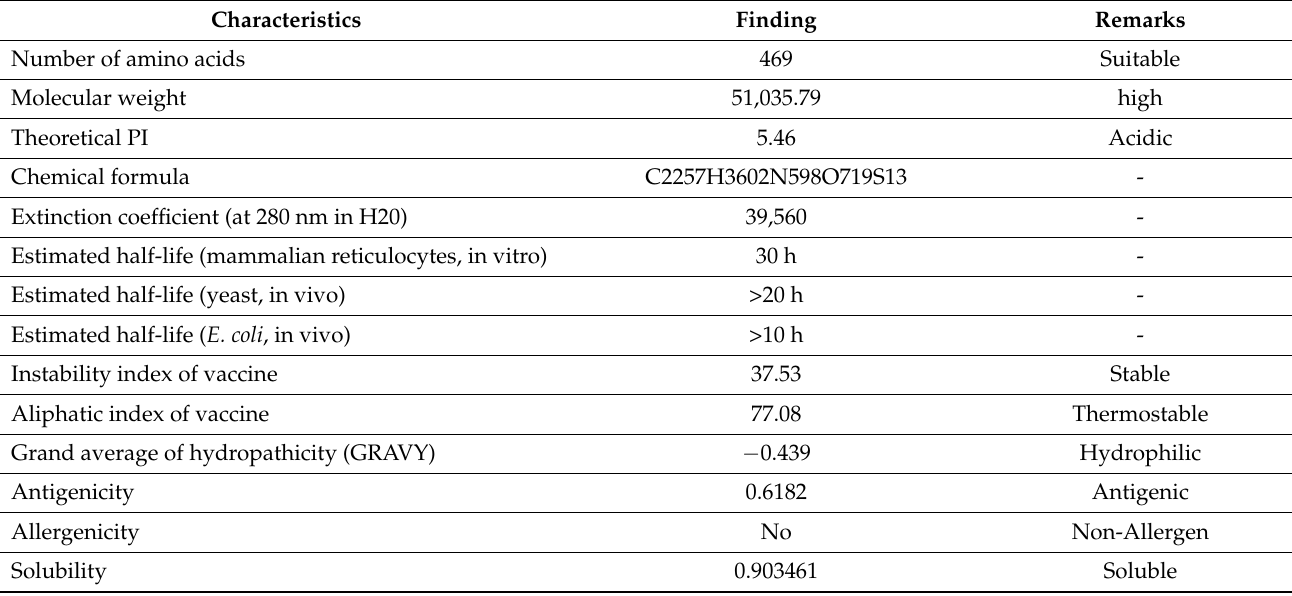
Table 4. Antigenic, allergenic, and physiochemical characteristics of the construct.